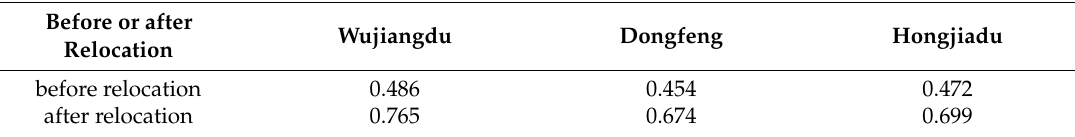
Table 3. Comprehensive membership value before and after relocation caused by the Wujiangdu, Dongfeng, and Hongjiadu Power